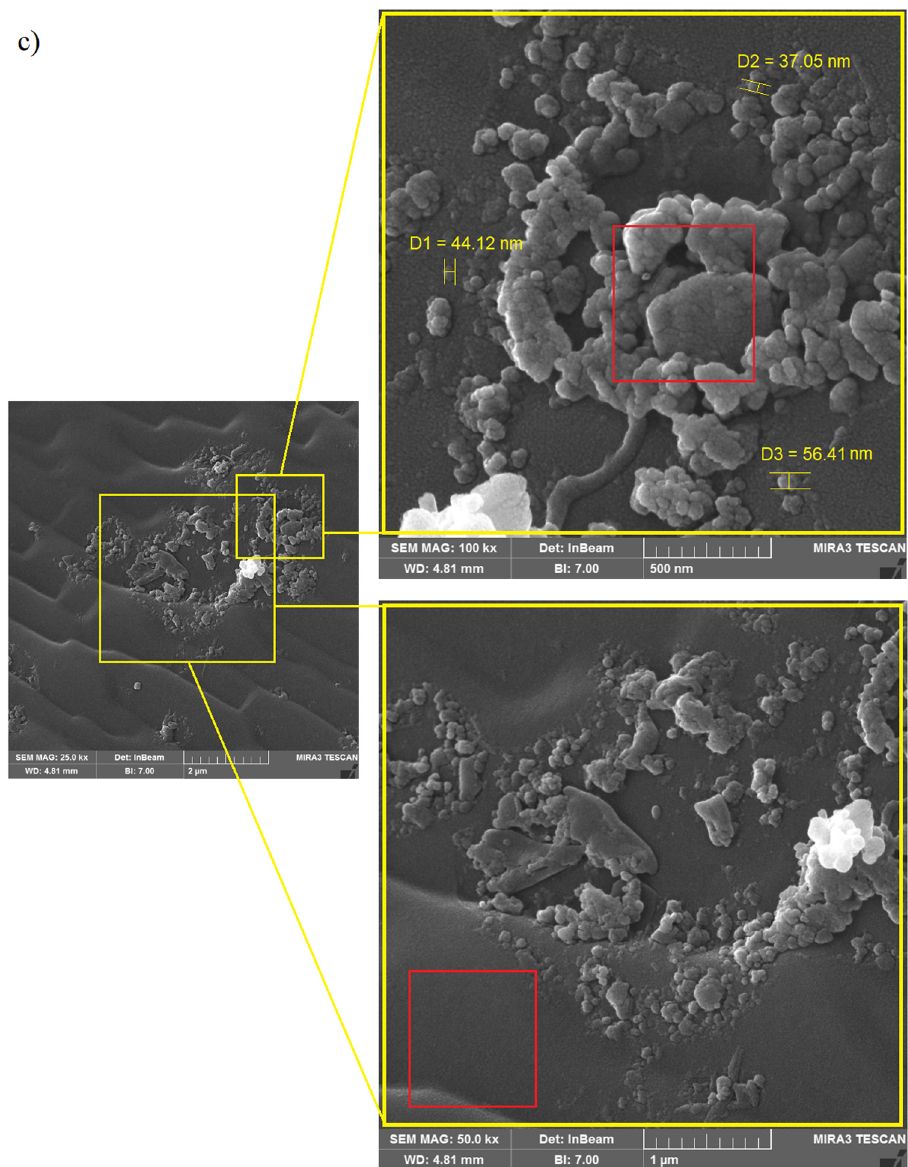
Figure 2: ( a ) FESEM images of asphalt binder modi fi ed by CSNPs at di ff erent magni fi cations. ( b ) FESEM colored images of CSNPs on binder surface; CSNPs coat a large surface of the binder due to the high surface area - to - volume ratio ( one of the unique physical properties of CSNPs ) . The red shows an aggregation of NPs, and green demonstrates the asphalt binder surface. ( c ) FESEM images of asphalt binder surface at di ff erent scales and aggregation sizes of CSNPs. The fi rst red square illustrates the aggregate of CSNPs, and the second red square shows the surface of the asphalt binder. The average size of CSNPs is 45